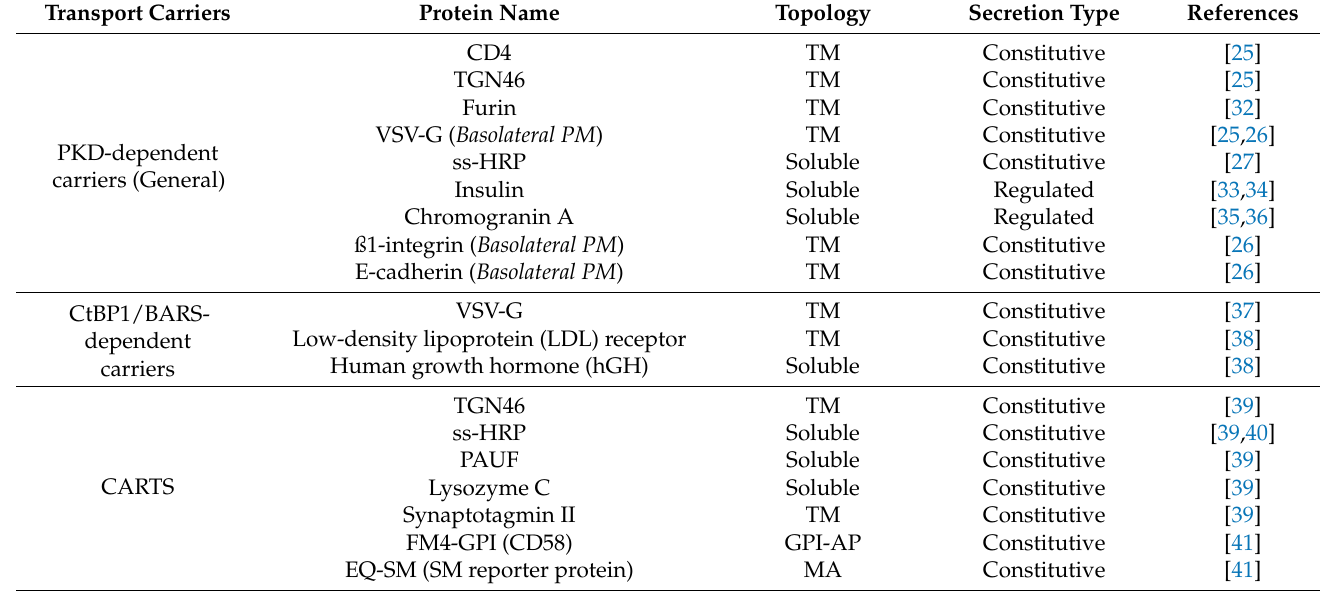
Table 1. Protein cargoes in TGN-to-PM transport carriers. The transport carriers considered here do not necessarily describe completely different export routes, because they share some machinery and cargoes (see text for details). However, since these transport carriers have been defined and characterized as such in the literature, we describe them separately here.